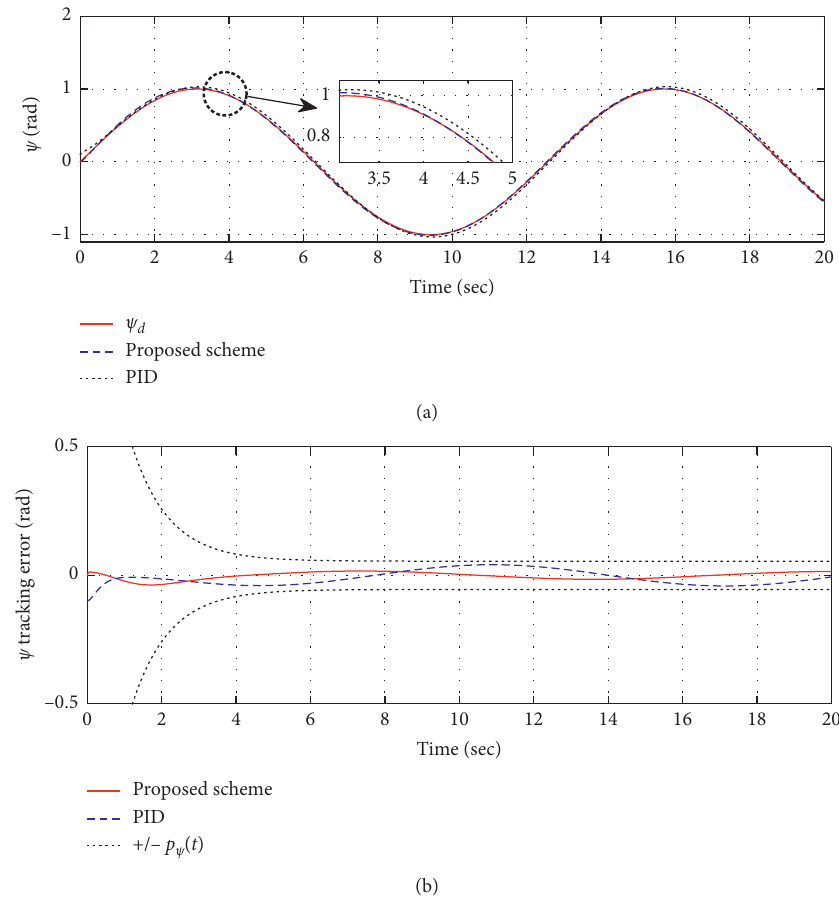
Figure 9: The tracking trajectory of ψ